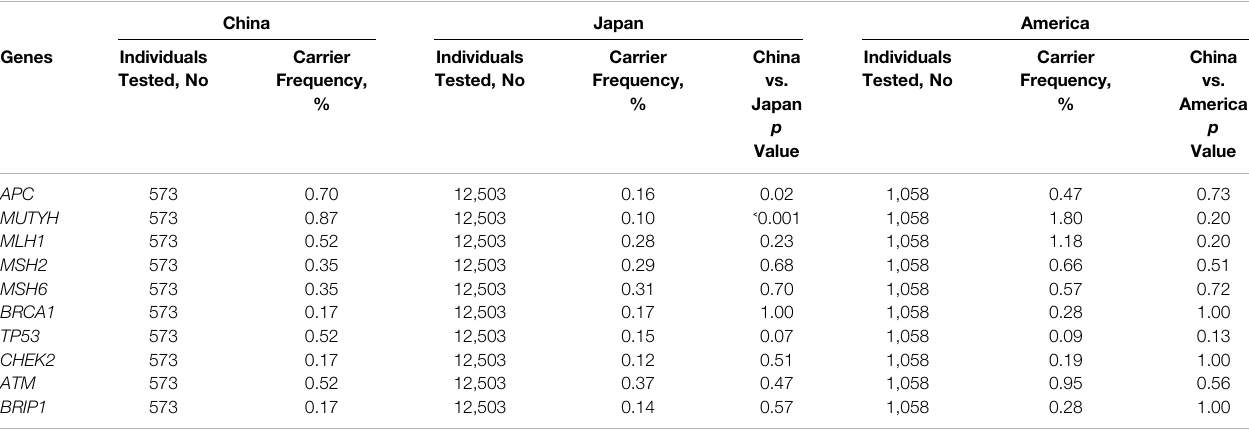
TABLE 4 | Comparison of germline mutation carriers with speci fi c genes among different